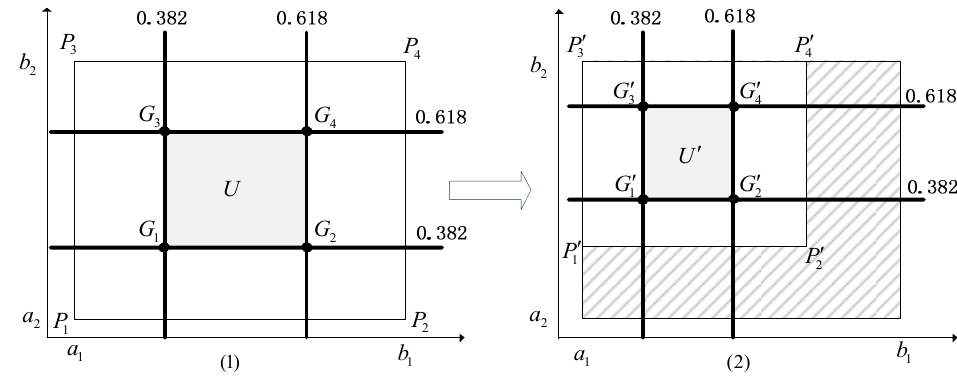
Figure 4. Diagram of the combination of constrained two-dimensional optimum seeking method and least square regression (CTOS & LSR), P 1 , P 2 , P 3 , and P 4 are four corners of the rectangle U determined by the feasible region of the estimated two-dimensional variables, G 1 , G 2 , G 3 , and G 4 are interior points of U determined by the golden section method, P 1 (cid:48) , P 2 (cid:48) , P 3 (cid:48) , and P 4 (cid:48) are four corners of the rectangle U obtained by one iteration calculation of CTOS & LSR;